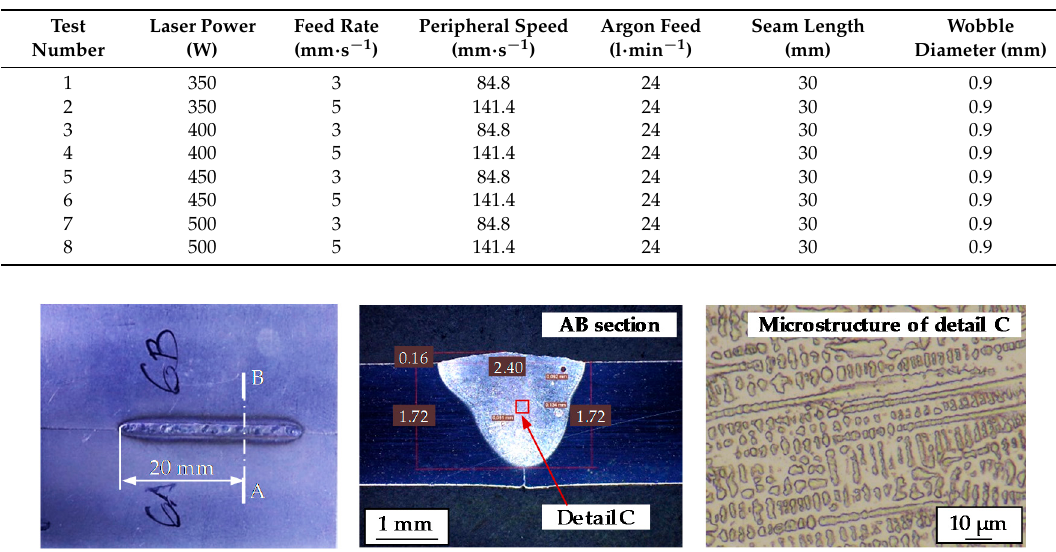
Figure 5. Upper view ( left ), cross section ( center ) and detail of the microstructure ( right ) of the Test 6. Table 3. Process parameters for the different tests.